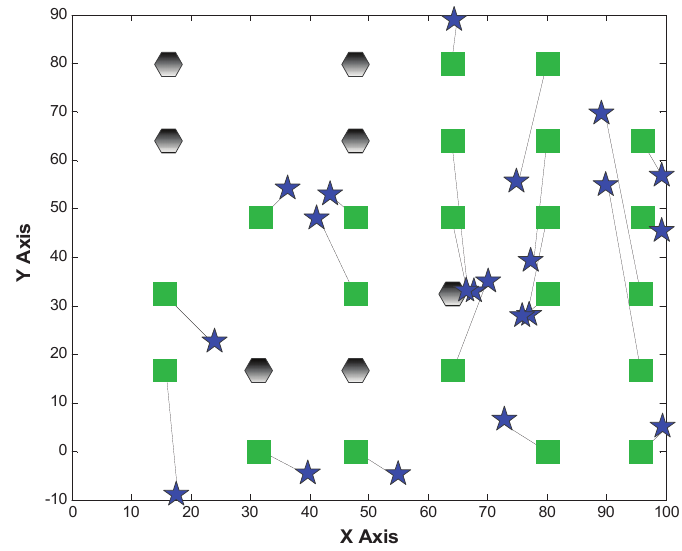
Figure 12. Localization results of